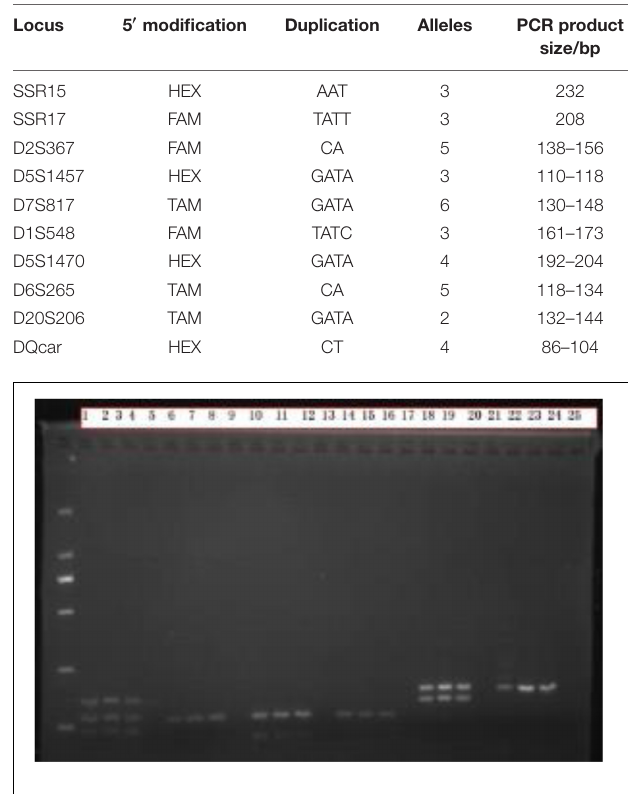
FIGURE 3 | Sex identification electrophoresis test results. Males have 2–3 bands, females have only 1 band, and numbers 1–8 are the PCR products of Scheme A. The blank control group does not have any bands, the target band is bright, and the background is clean; Numbers 9–16 are the PCR products of Scheme B. The blank control group has no bands, the target bands have a clean background, and the bands are fuzzy; Numbers 17–25 are the PCR products of Scheme C. The blank control group has no bands, the target bands are bright, and the background is clean, but some samples have nonspecific